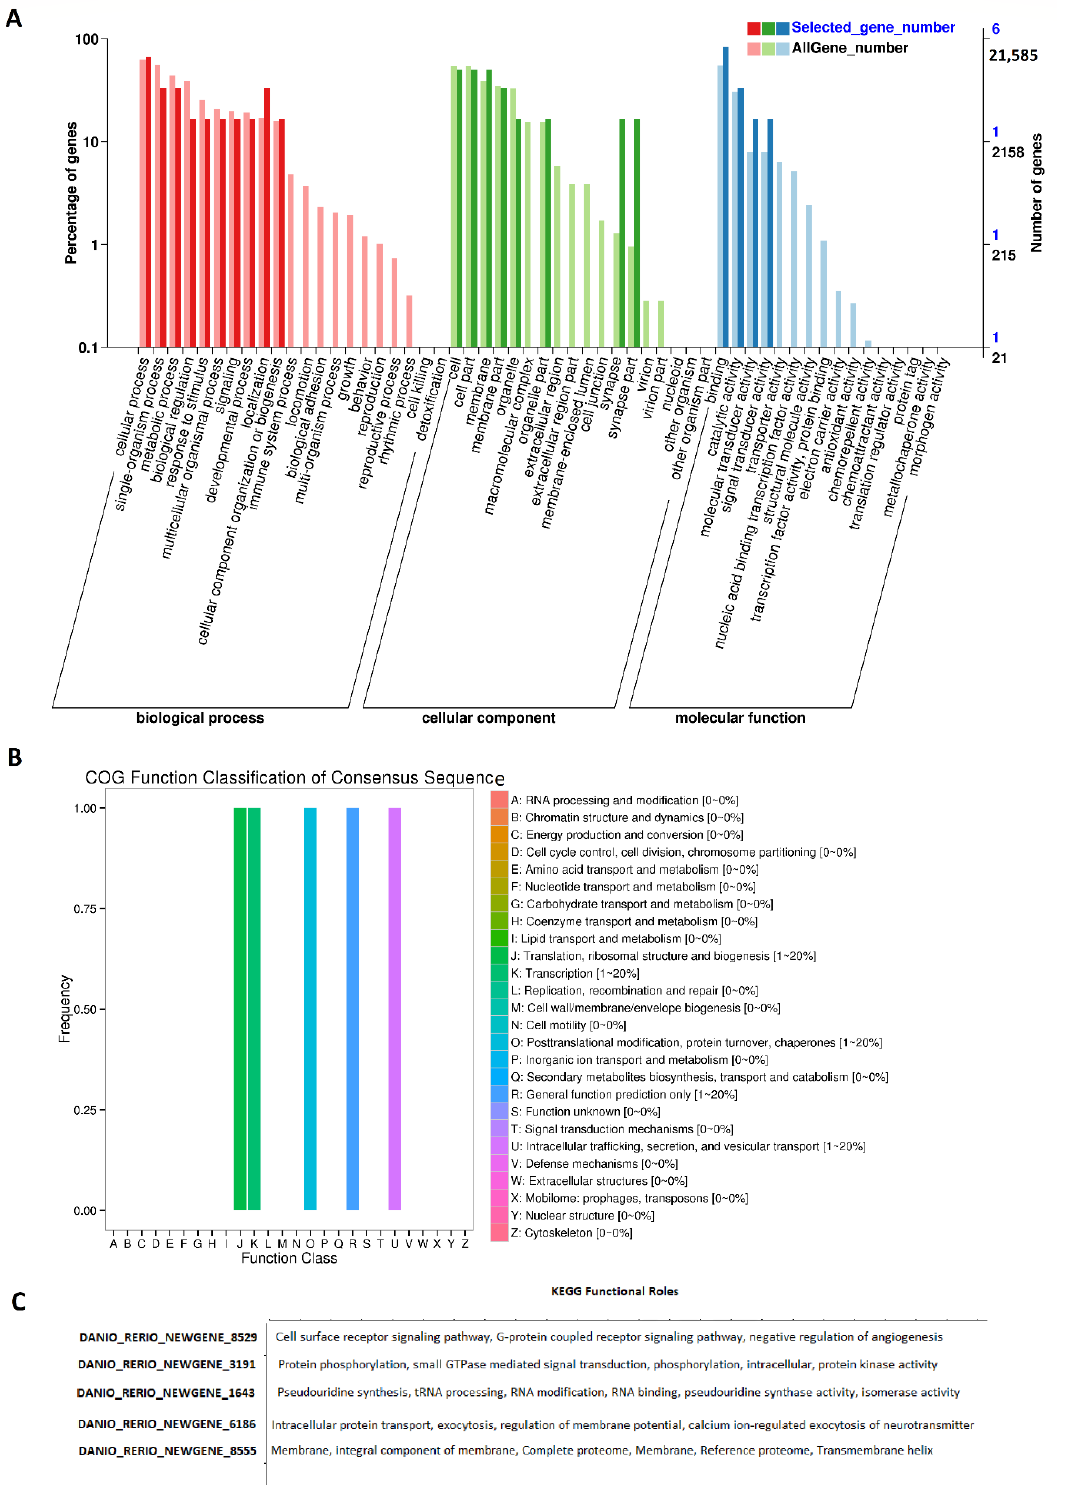
Figure 4. GO, COG, and KEGG analysis of rhythmically expressed testis lncRNAs: GO annotation revealed the percentage of genes involved in different biological processes, cellular components (e.g., cell membrane part, macromolecular complex, and synapse), and molecular functions ( A ), COG functional classification of lncRNAs ( B ), and KEGG functional roles of the representative lncRNAs ( C